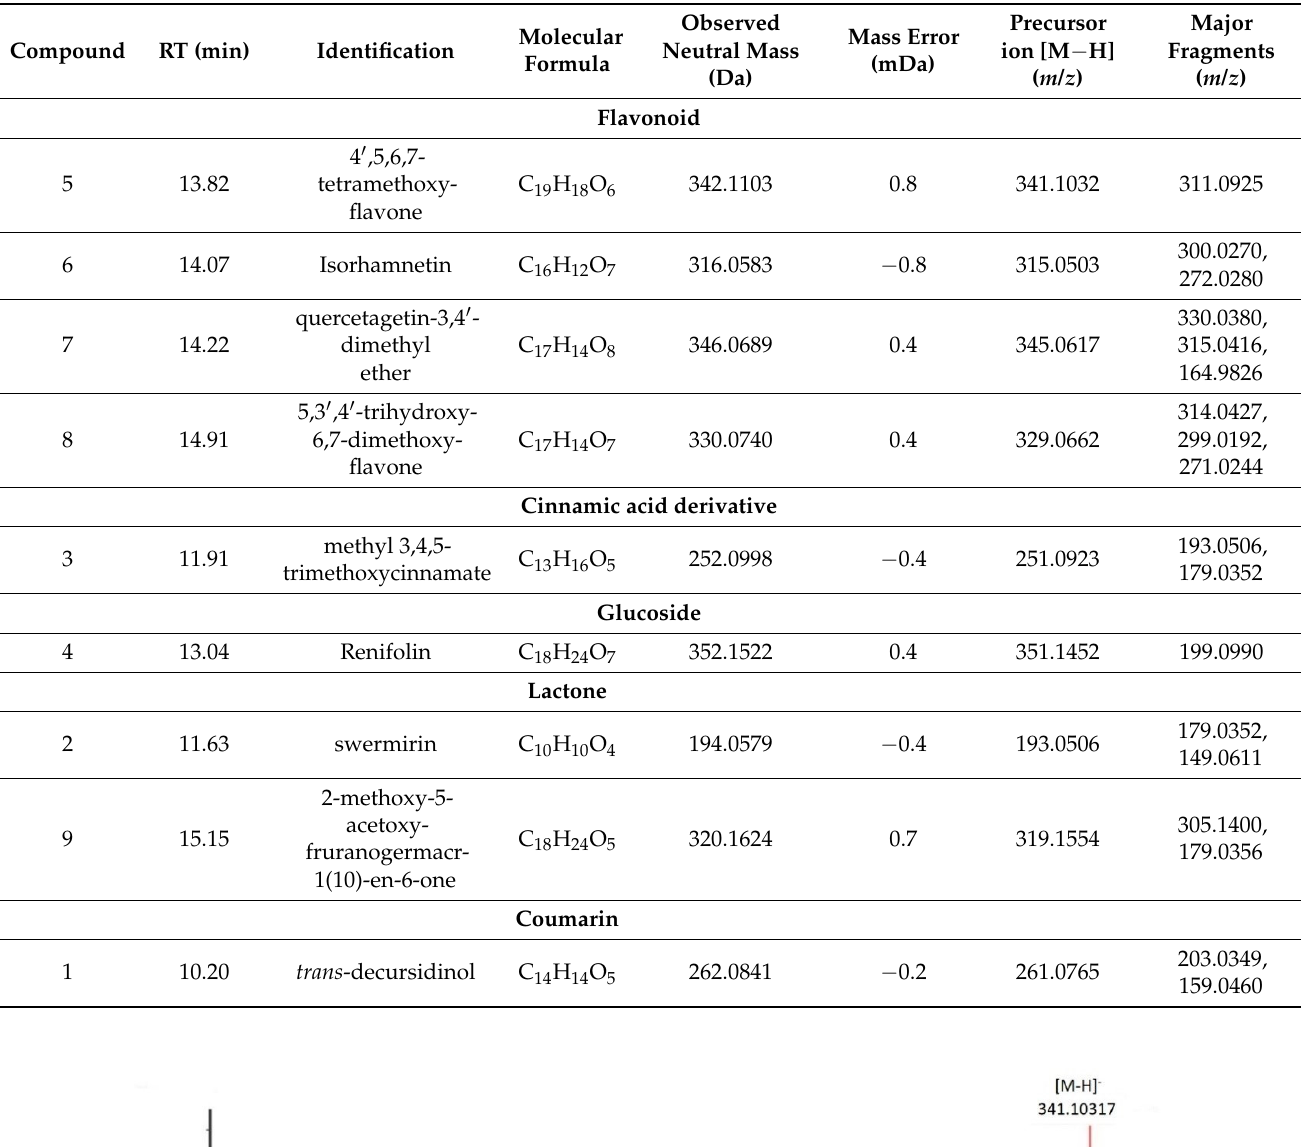
Major Precursor Observed Mass Error Molecular Fragments ion [M − H] Neutral Mass (mDa) Formula ( m / z ) ( m / z ) (Da)